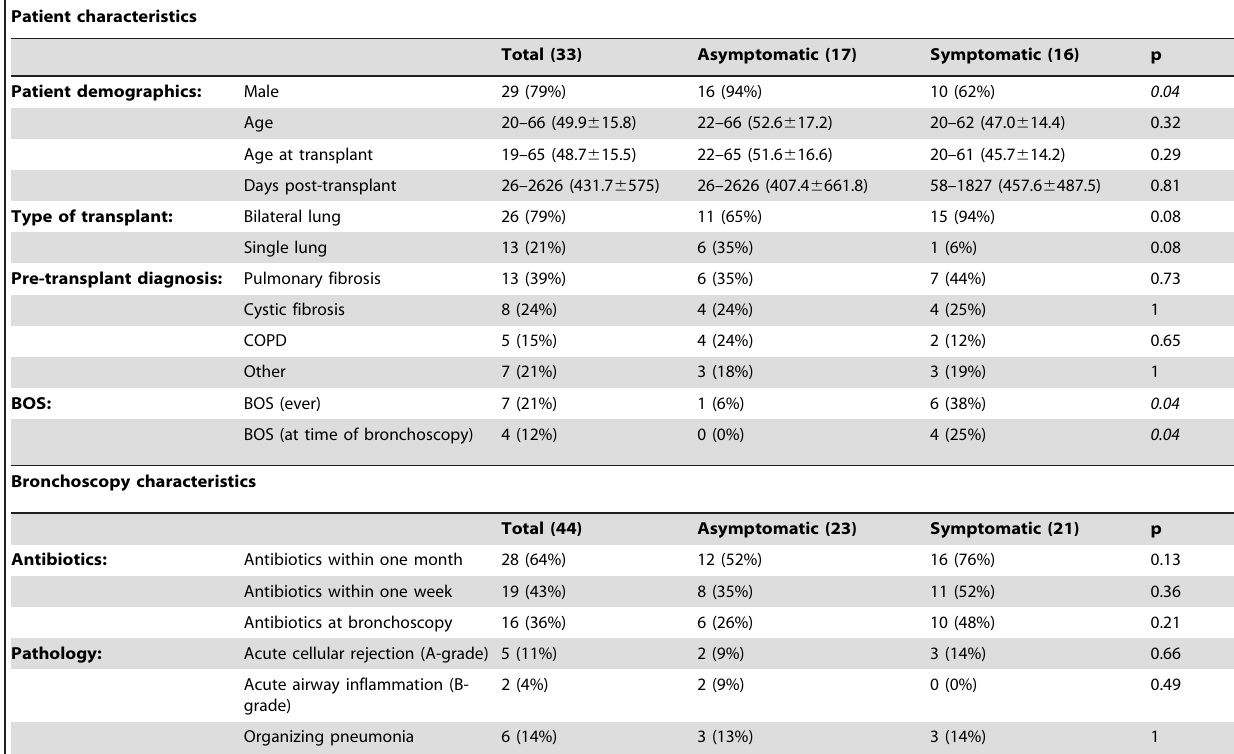
Table 1. Patient and Bronchoscopy Characteristics.